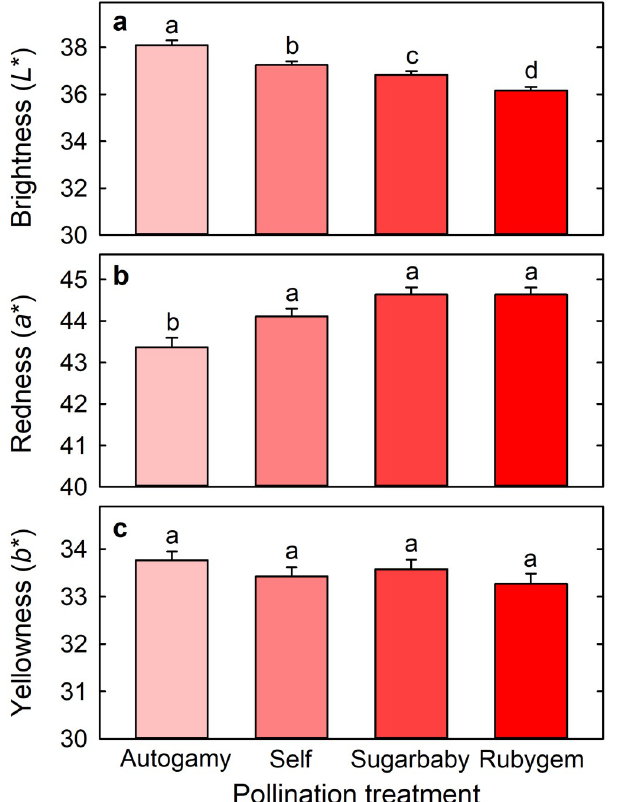
Fig 3. (a) Brightness (L � ), (b) redness (a � ), and (c) yellowness (b � ) of Redlands Joy strawberry fruit arising from unassisted self-pollination (Autogamy) or hand-pollination with self-pollen (Self) or cross-pollen from another cultivar (Sugarbaby or Rubygem). Means + SE with different letters are significantly different (GLM; P < 0.05; n = 460–521 fruit).